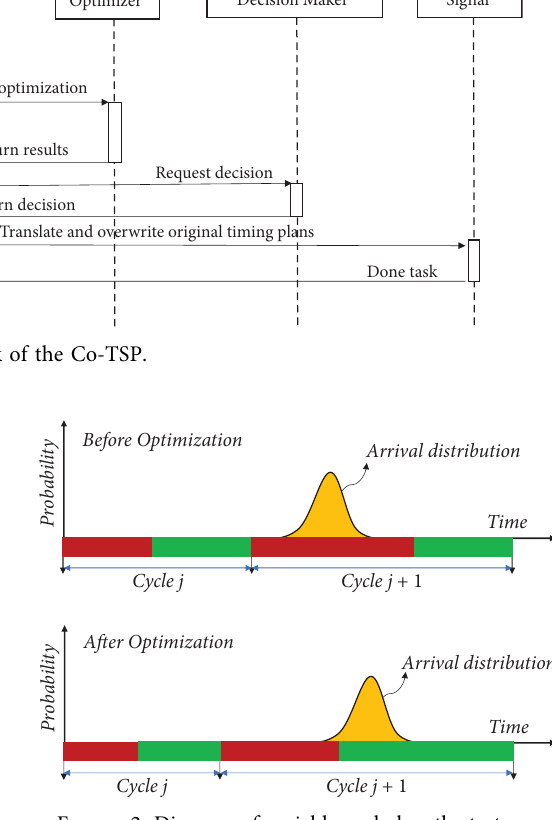
Figure 2: Diagram of variable cycle length